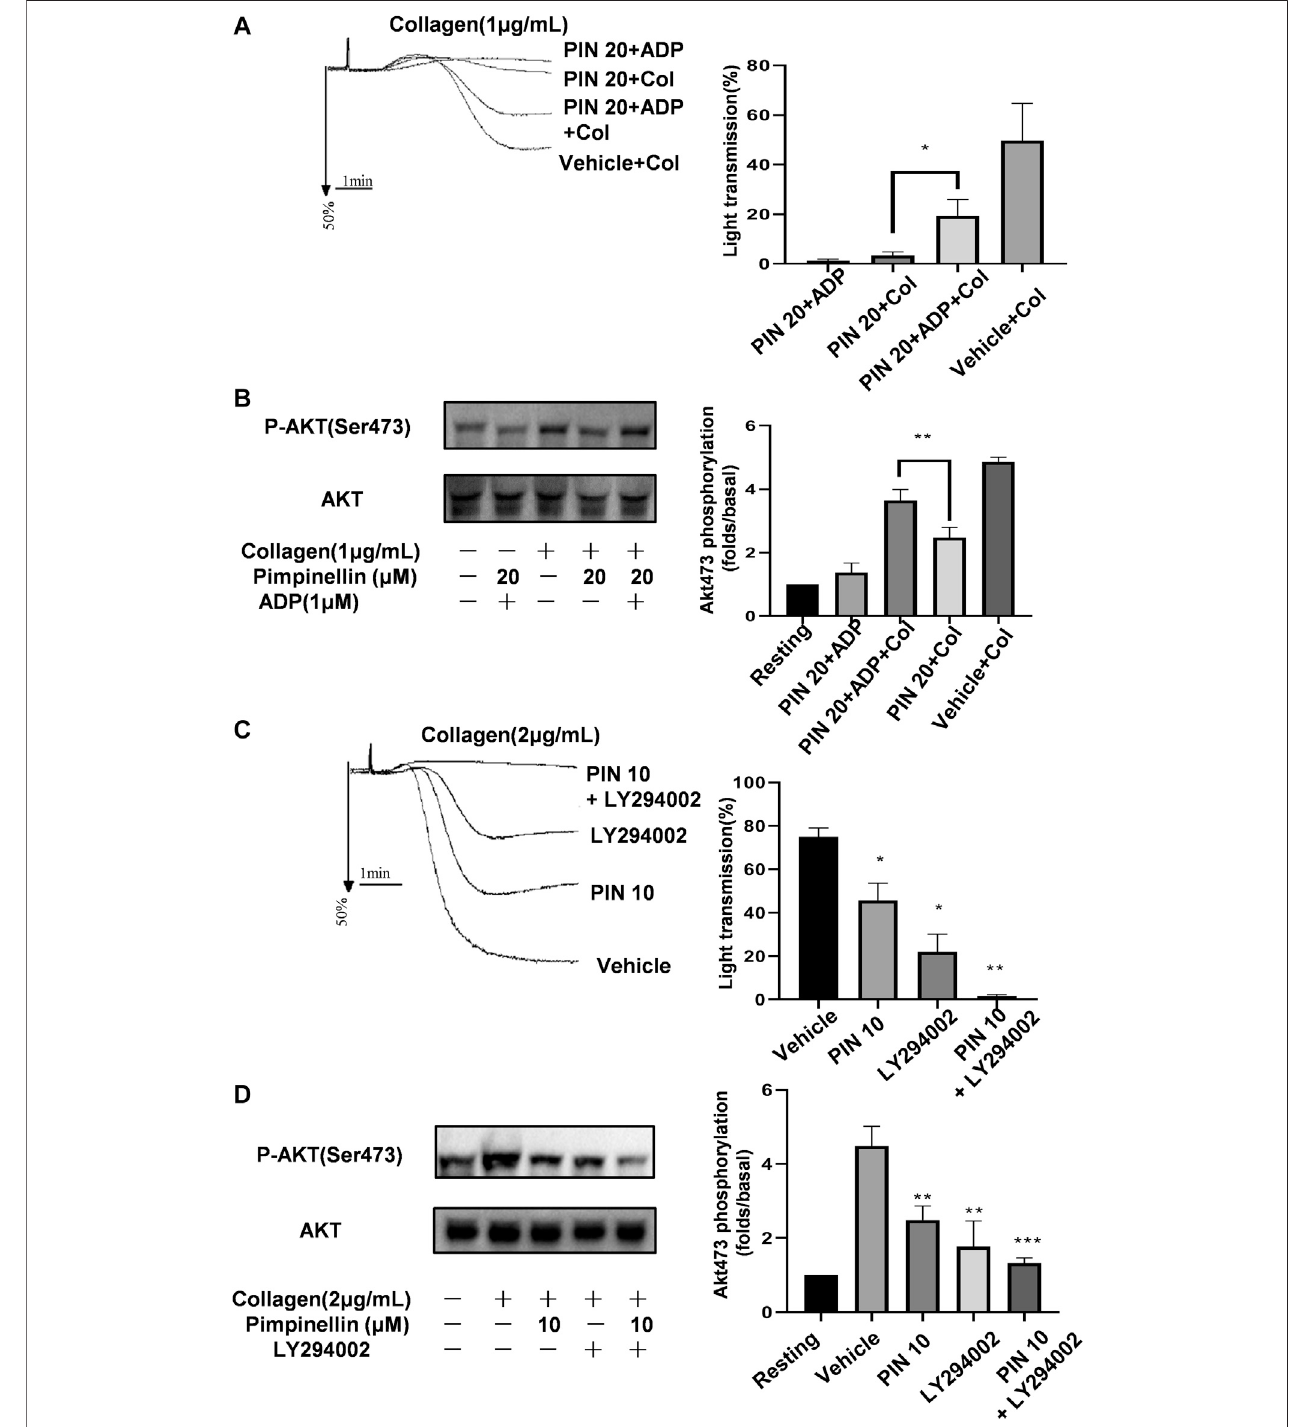
FIGURE 6 | Effects of pimpinellin on platelet aggregation in the presence of ADP or LY294002. (A) Washed platelets (3 × 10 8 /ml) were pretreated with 20 μ M pimpinellin,1 μ MADPorbothfor10 minafterwhichtheywerestimulatedwithcollagen(1 μ g/ml).Plateletaggregationrateswerecalculatedinatleastthreeindependent experiments and the results are shown as mean ± SEM (* p < 0.05 compared with the PIN 20+Col group, PIN 20 means pimpinellin 20 μ M, COL means collagen). (B) LysatesfromeachgroupwereanalyzedbyimmunoblottingtodeterminetheAktphosphorylationlevels. (C) Washedplatelets(3 × 10 8 /ml)werepre-incubatedwith 10 μ M pimpinellin, 2 μ M LY294002 or both for 10 min, after which they were stimulatedwith2 μ g/ml collagen. (* p < 0.05 and ** p < 0.01 compared tothe vehiclegroup, PIN 10meanspimpinellin10 μ M). (D) Lysatesineach groupwereanalyzed byimmunoblottingtodetermine theAktphosphorylationlevels.Banddensity wascalculated by the ImageJ software. Bar graphs represent the mean ± SEM ( n (cid:2) 3).